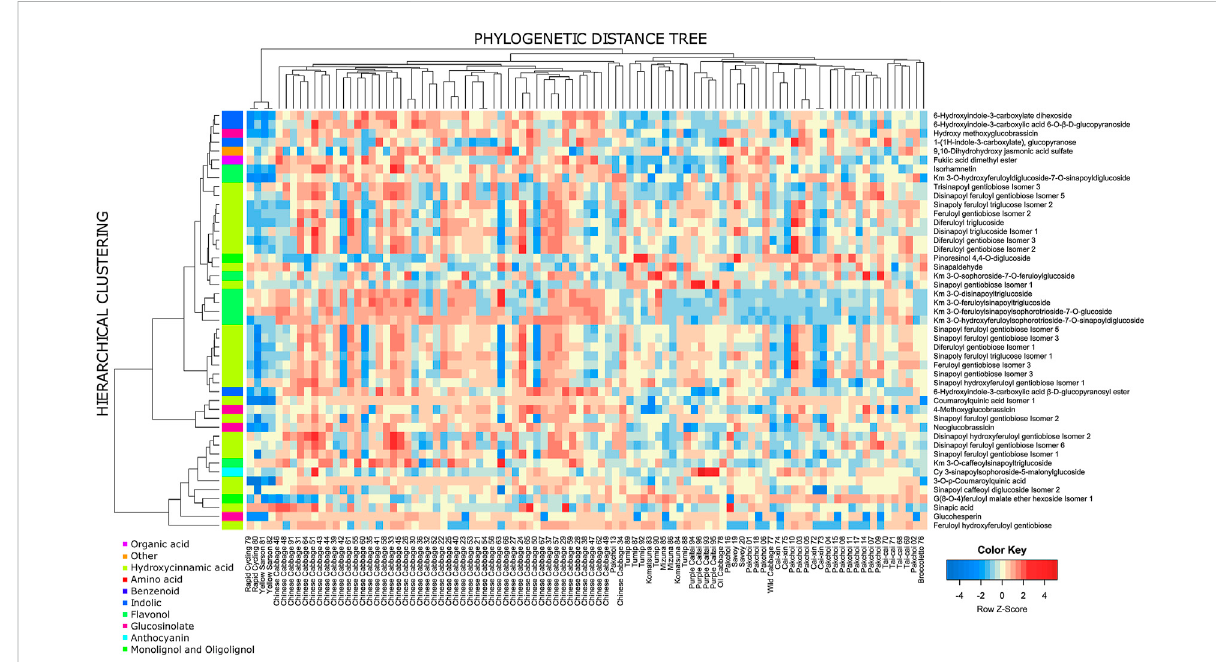
FIGURE 5 Heatmap of compounds exhibiting signi fi cant phylogenetic signal ( p -value ≤ 0.05). The side color sidebar represents the classi fi cation of measured compounds to 10 biochemical classes. The row-wise clustering tree is based on the Euclidean distance between Z-transformed metabolite levels, and the average linkage method for cluster agglomeration. The column tree is a midpoint-rooted phylogenetic